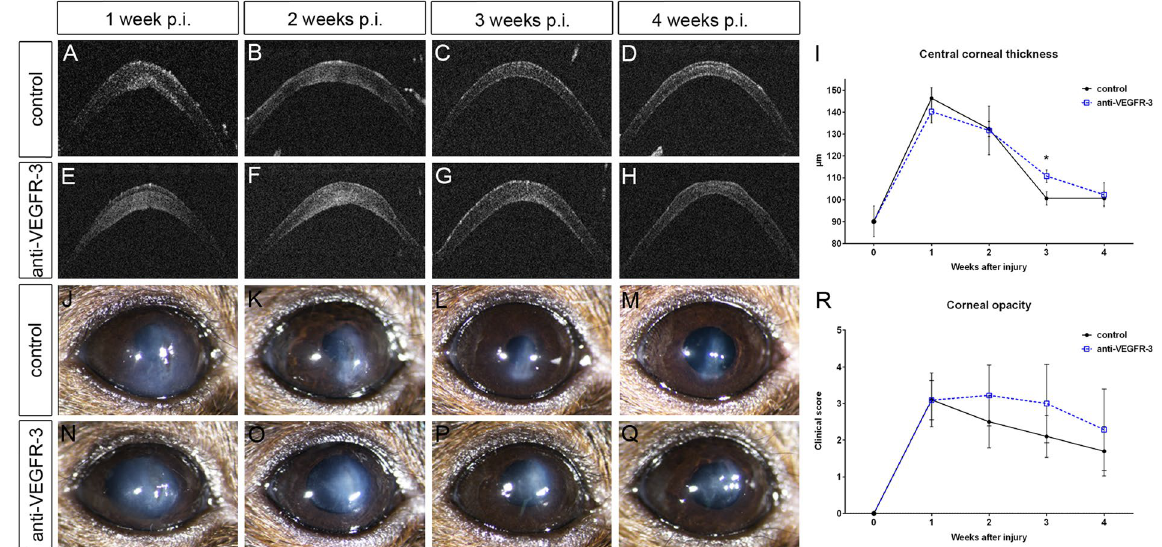
Figure 2. Blockade of lymphangiogenesis results in delayed resolution of corneal edema and prolonged opacification. Mice were treated with the anti-VEGFR-3 antibody mF4-31C1 (500 µ g, intraperitoneally) directly before, on day 3, 6, 9, and 12 after incision injury or equal amounts of PBS. (A – H) In vivo optical coherence tomography scans of the anterior segment measuring central corneal thickness (CCT); (I) Blockade of corneal lymphangiogenesis resulted in delayed regression of CCT. ( J – Q ) Clinical images of injured corneas; (R) Blockade of lymphangiogenesis resulted in a trend towards higher opacity scores. p.i.: post injury; data are shown as mean + / − SD; n = 5–10 per group per time point; statistical analysis was performed using the unpaired 2-tailed Student’s t test * : p < 0.05.